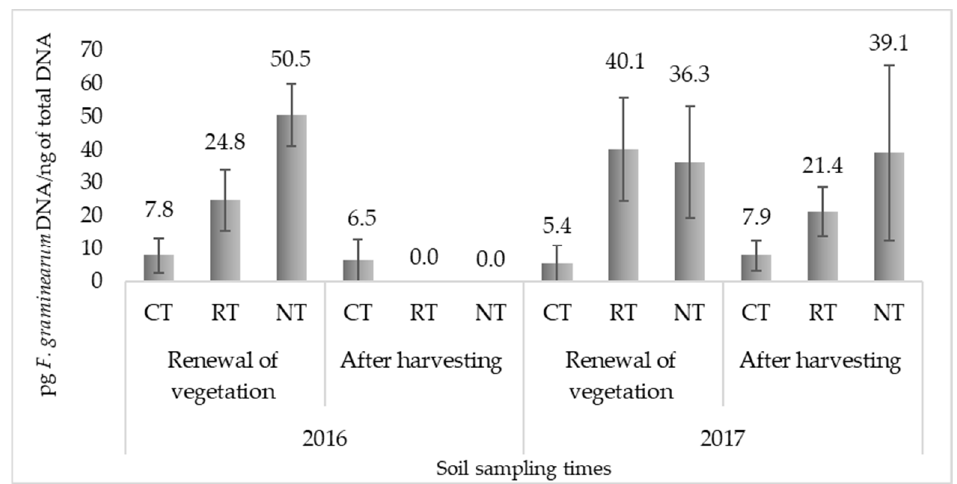
Figure 1. F. graminearum DNA (pg F. graminearum DNA/ng of total DNA) content obtained in